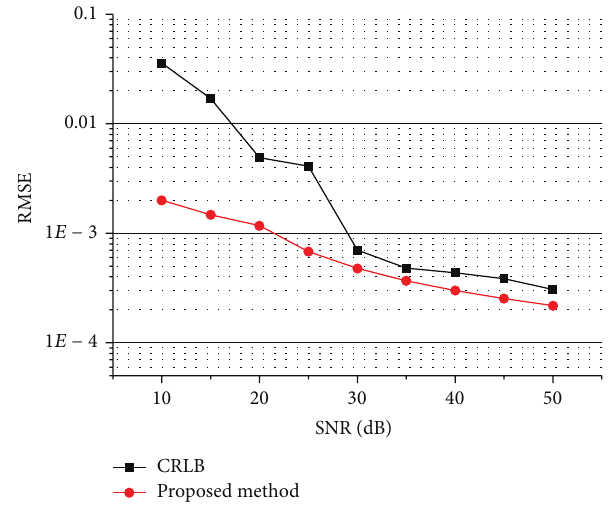
Figure 5: Performance of the proposed method.